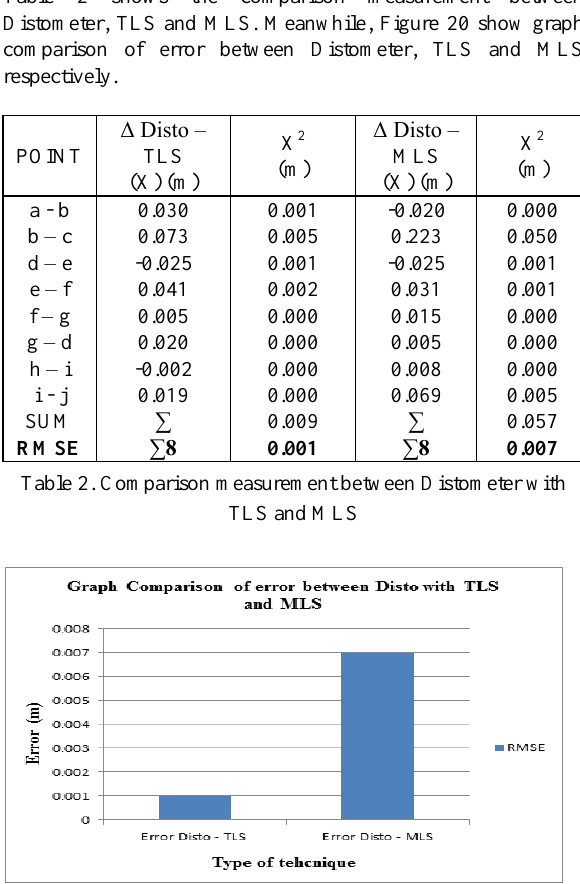
Figure 20. Graph comparison of error between Distometer with TLS and MLS